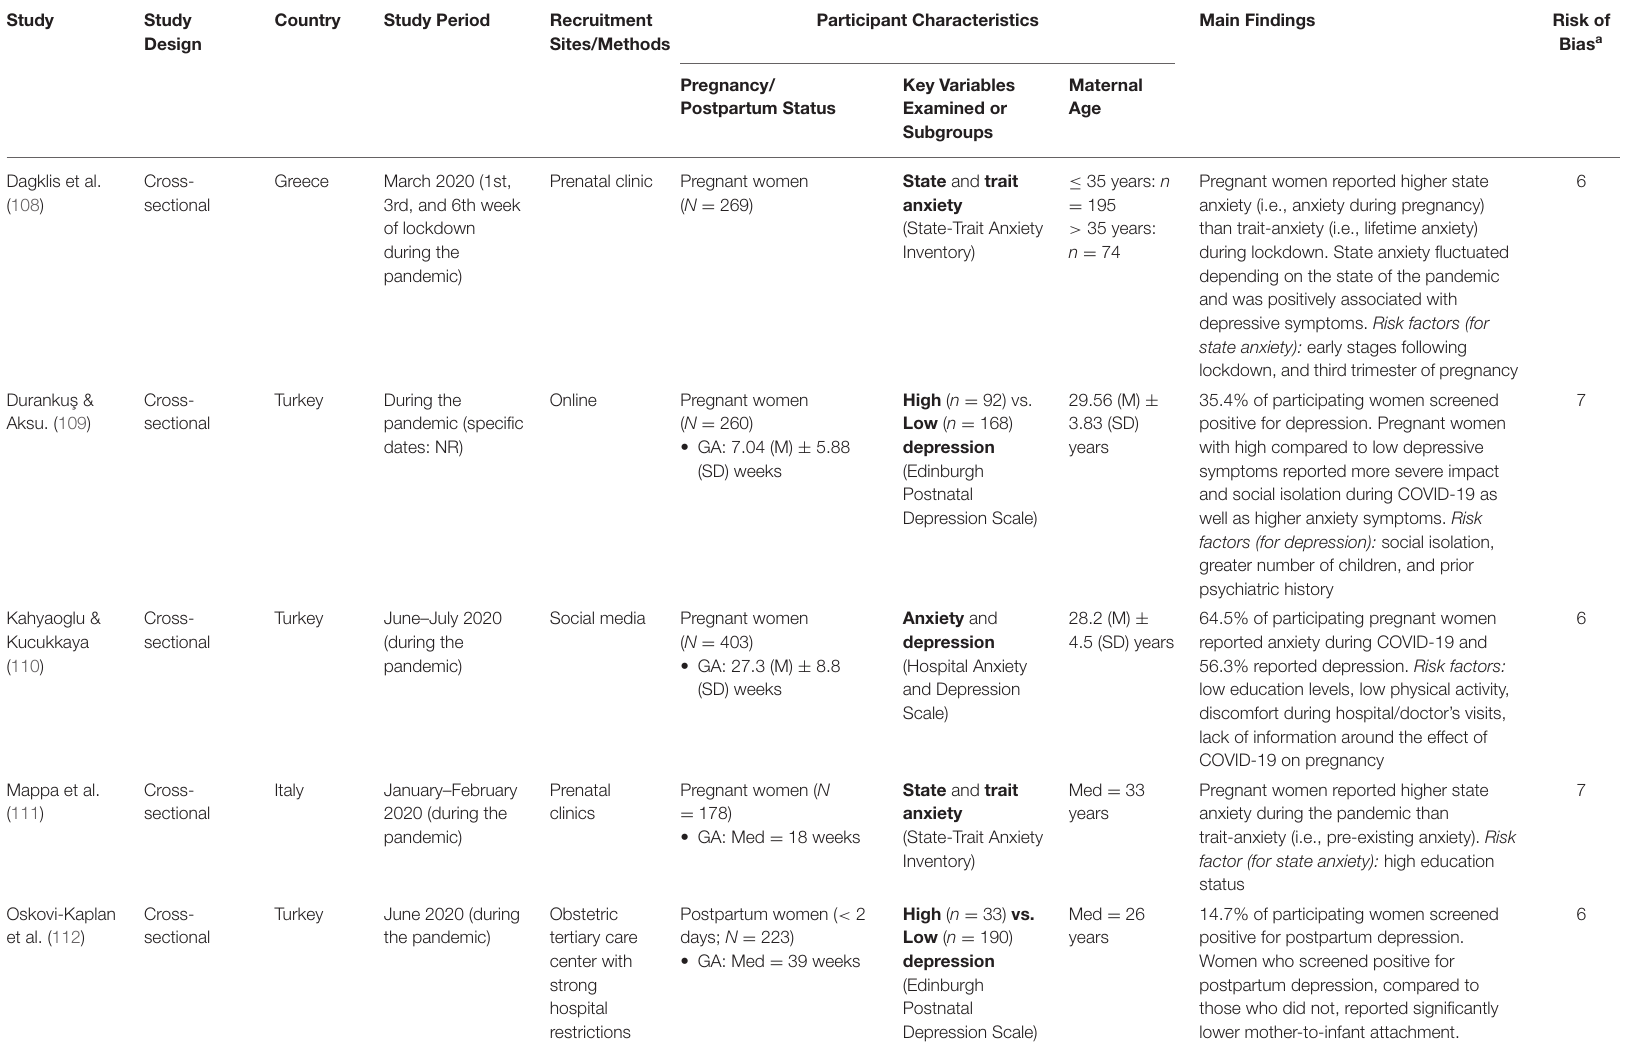
TABLE 7 | Perinatal mental health outcomes during COVID-19 as a function of depression or anxiety